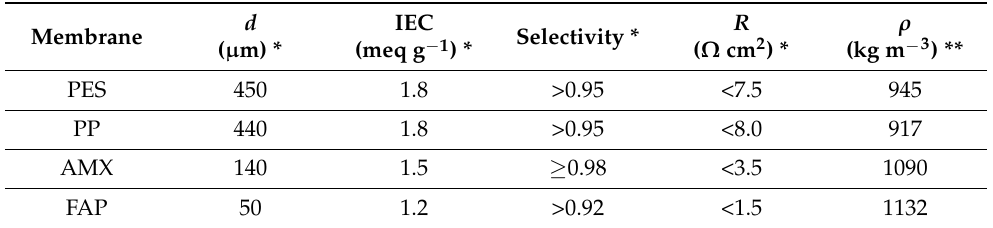
Table 1. Some properties of the used membranes. Thickness ( d ), ion exchange capacity (IEC), density ( ρ ), and electric resistance ( R ).